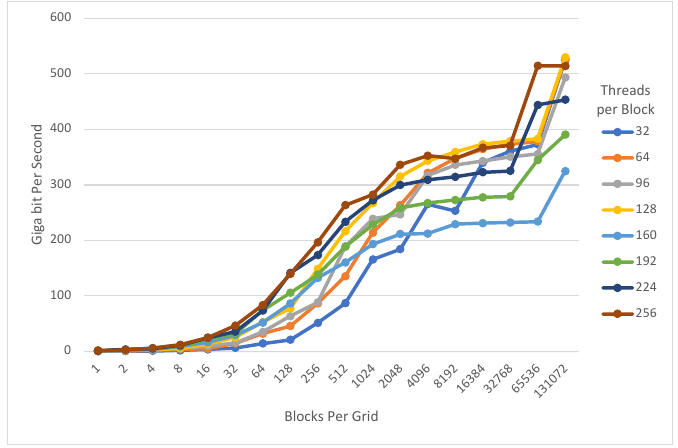
Figure 5. PRESENT-128 exhaustive key search: Comparison of the number of key-search per second.